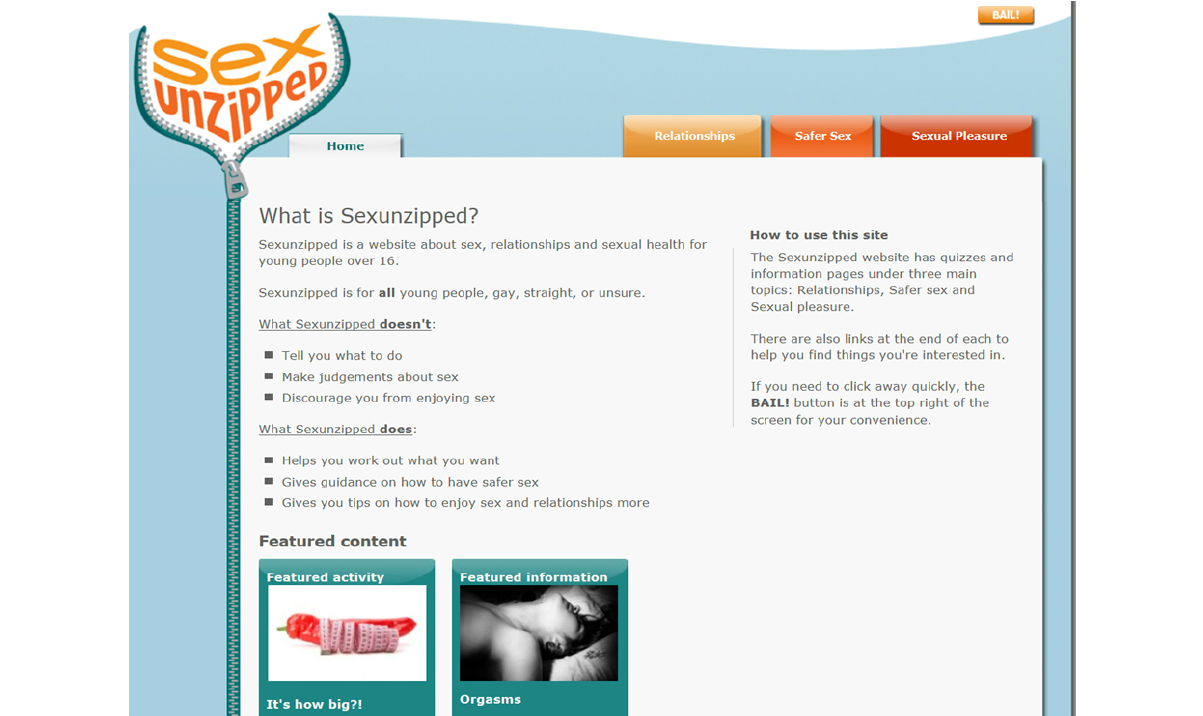
Figure 1. Screenshot of Sexunzipped